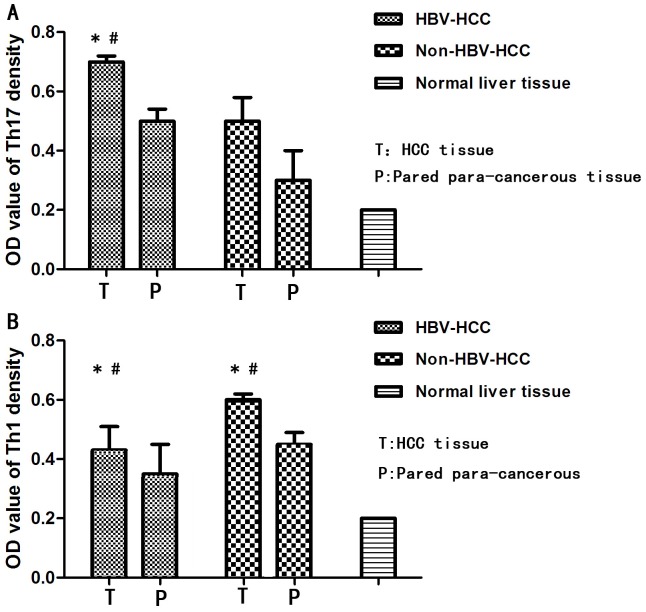
Optical densities (OD) of IL-17-producing (Th17) and IFN-γ-producing (Th1) cells in cancerous and non-cancerous tissues.(A)The density of Th17 cells was significantly higher in tumor (T) and paired para-cancerous (P) tissues from patients with HBV-related HCC than in tissues from patients with non- HBV-related HCC. (B)The density of Th1 cells was significantly lower in T and P tissues from patients with HBV-related HCC than in tissues from patients with non- HBV-related HCC. (* and # indicate P<0.01).